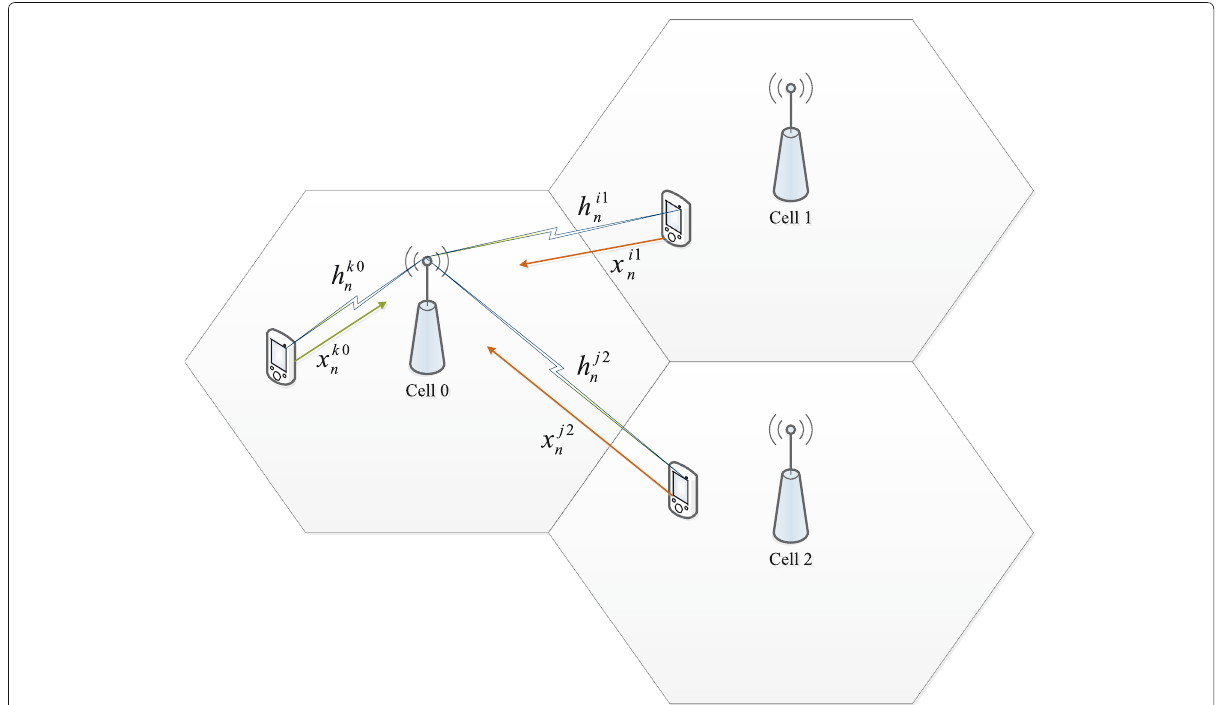
Fig. 1 A cellular system with three cells. Cell 0 is of interest and the neighboring cells will potentially cause interference (red arrows)